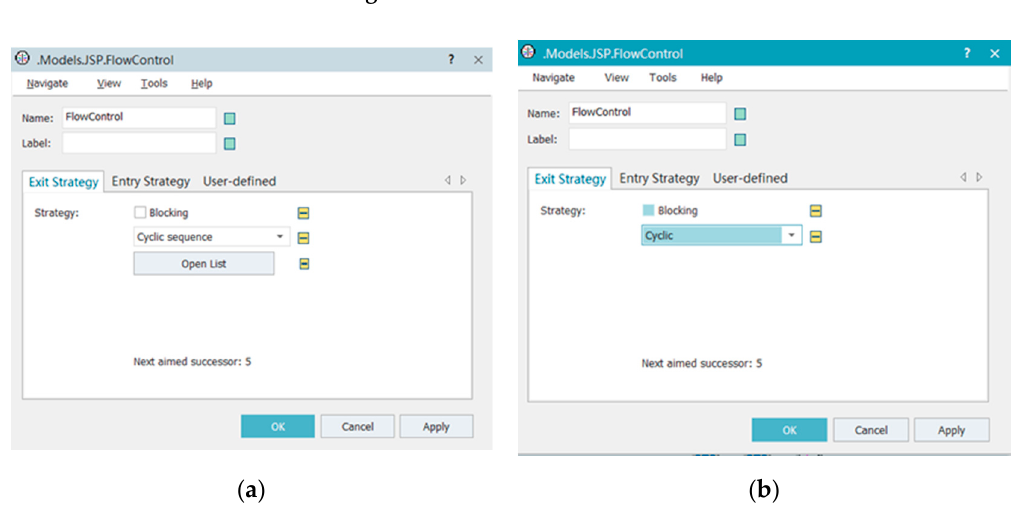
Figure 6. AGV loader simulation.